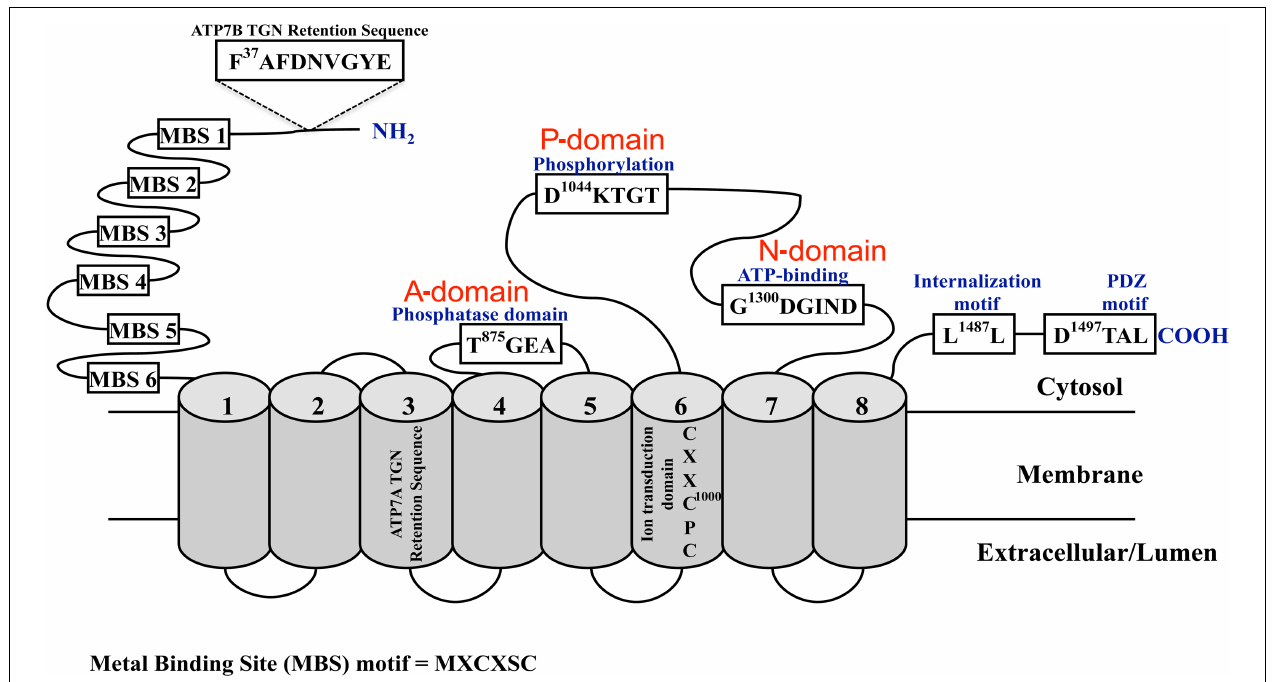
FIGURE 1 | Schematic diagram of the copper-ATPases,ATP7A andATP7B. Shown are the highly conserved domains: the N-terminal copper-binding domain, the phosphatase (A-domain), phosphorylation (P-domain), and